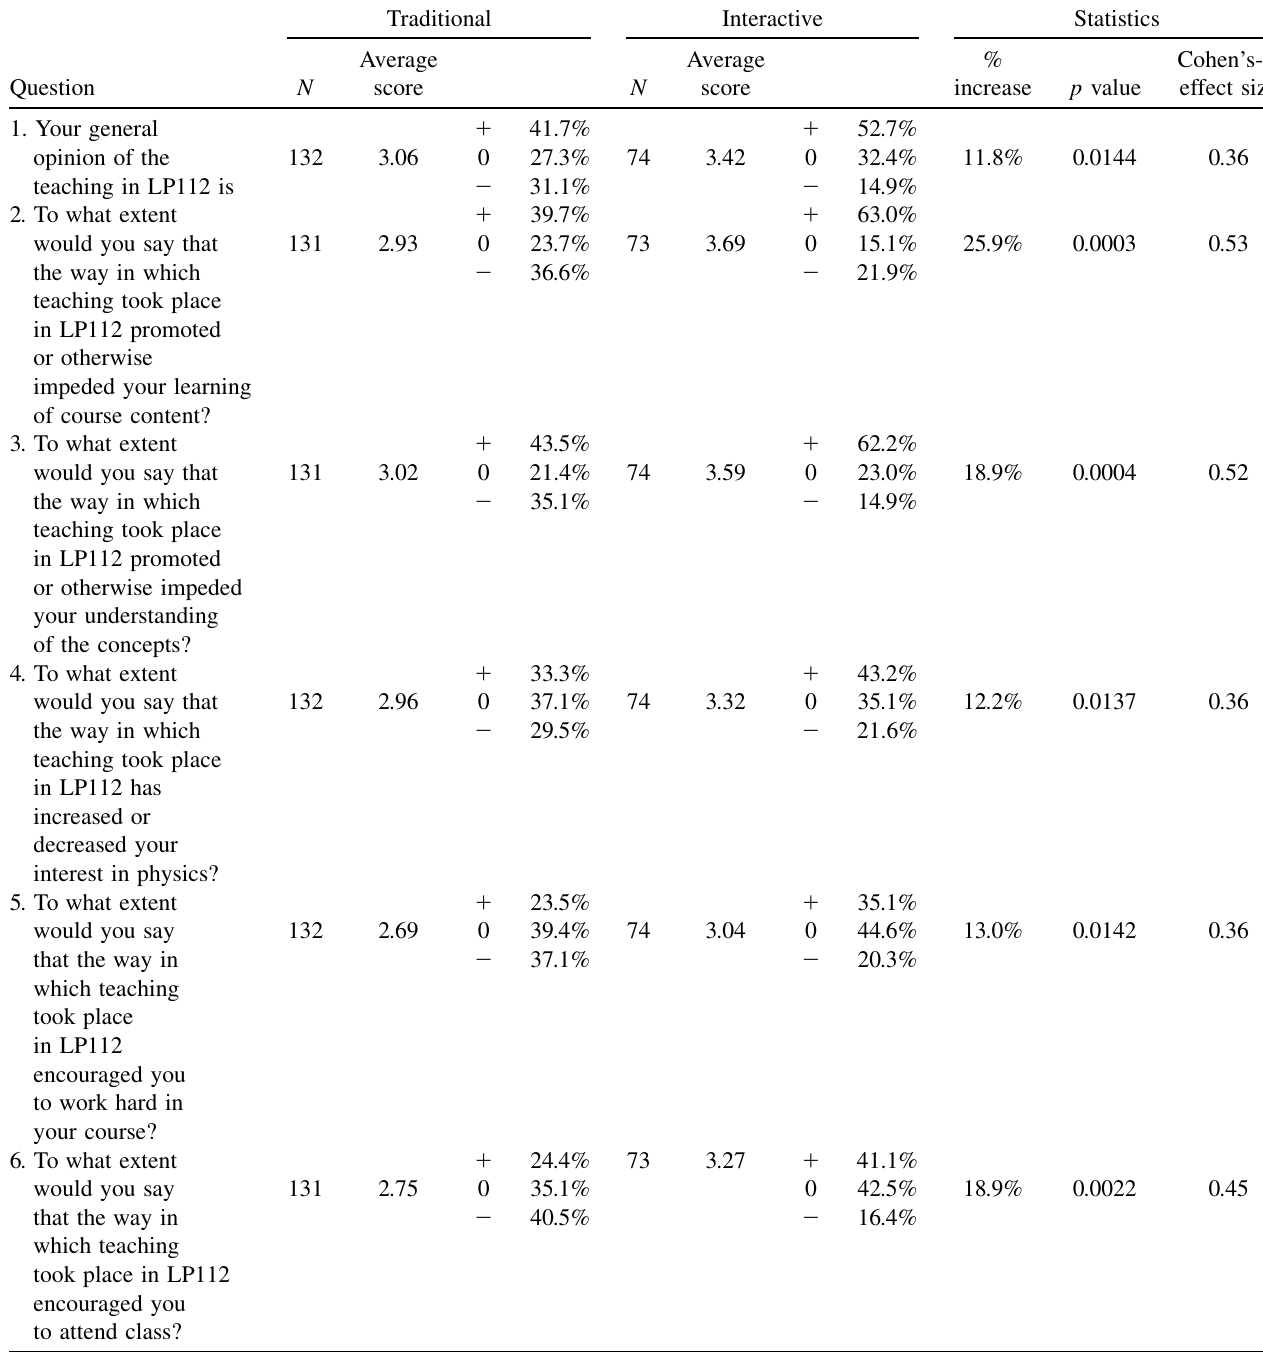
TABLE IX. Student year-end attitudes in second-semester Mechanics.